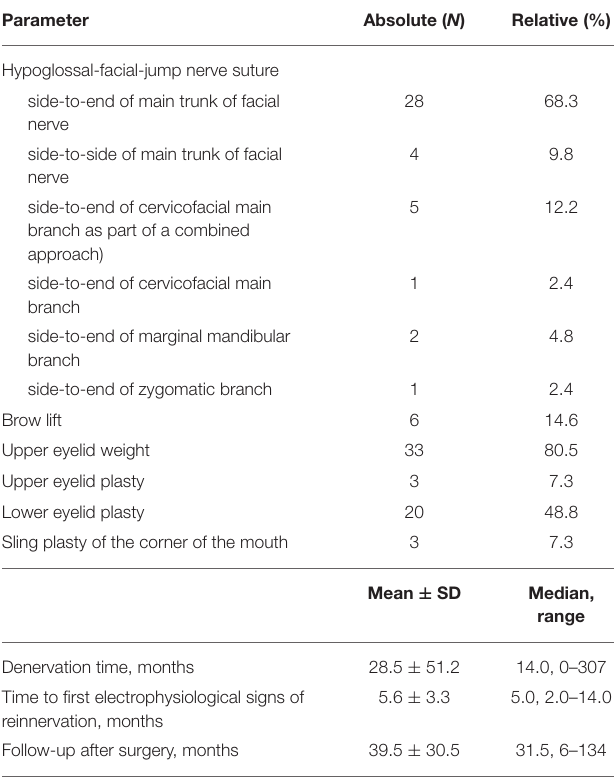
TABLE 1 | Surgical characteristics of the patients ( N = 41).